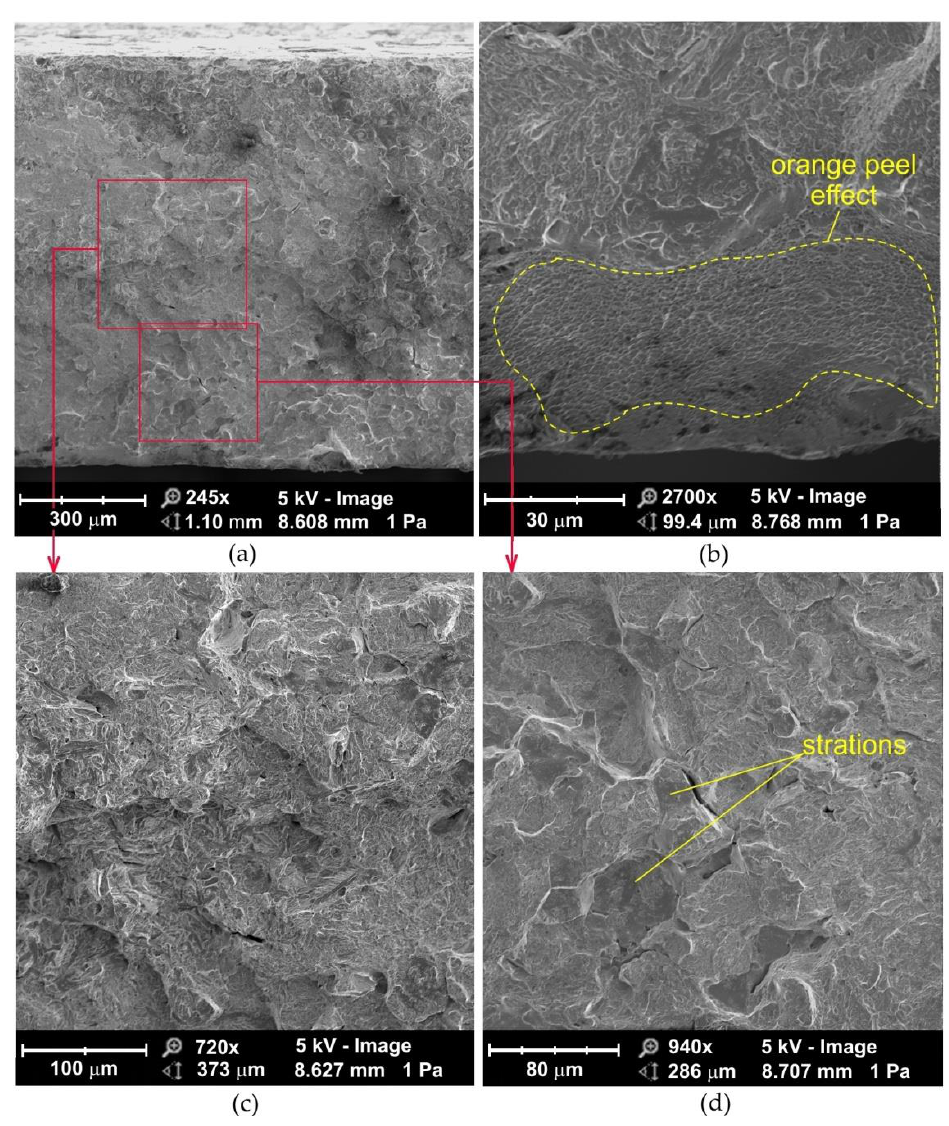
Figure 11. SEM micrographs of the fatigue fracture of sandblasted flash butt welded joints tested at a stress amplitude of 460 MPa: ( a ) cross-section of the fatigue fracture, ( b ) view of the near-edge layer of the weld, ( c ) magnification of the middle area of the weld, ( d ) magnification of the subsurface area of the weld.